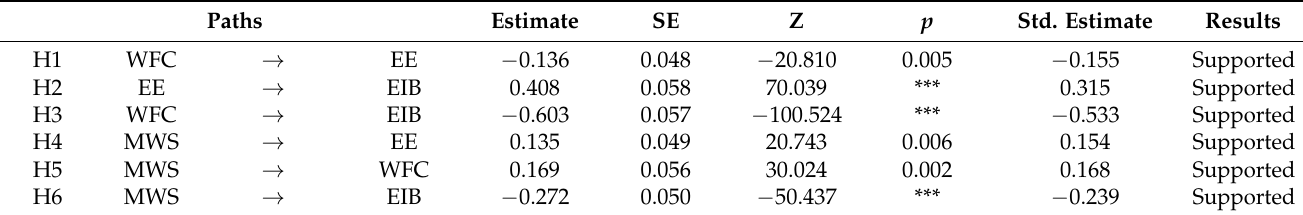
Table 4. Results of hypothesis testing through structural equation modeling.